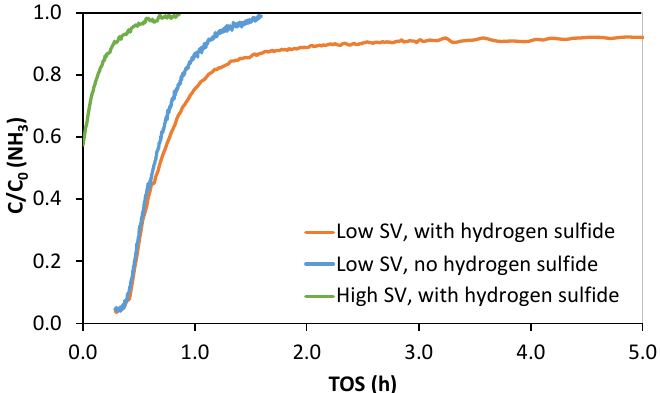
Figure 6. Continuous Fourier transform infrared spectroscopy (FTIR) measurement results of ammonia concentration for the experiments shown in Figure 5. The green line indicates the experiment conducted in reactor 1 and blue and orange lines in reactor 2. Ammonia feed concentration—35 ppm. The blue line indicates a control experiment conducted in syngas without H 2 S.